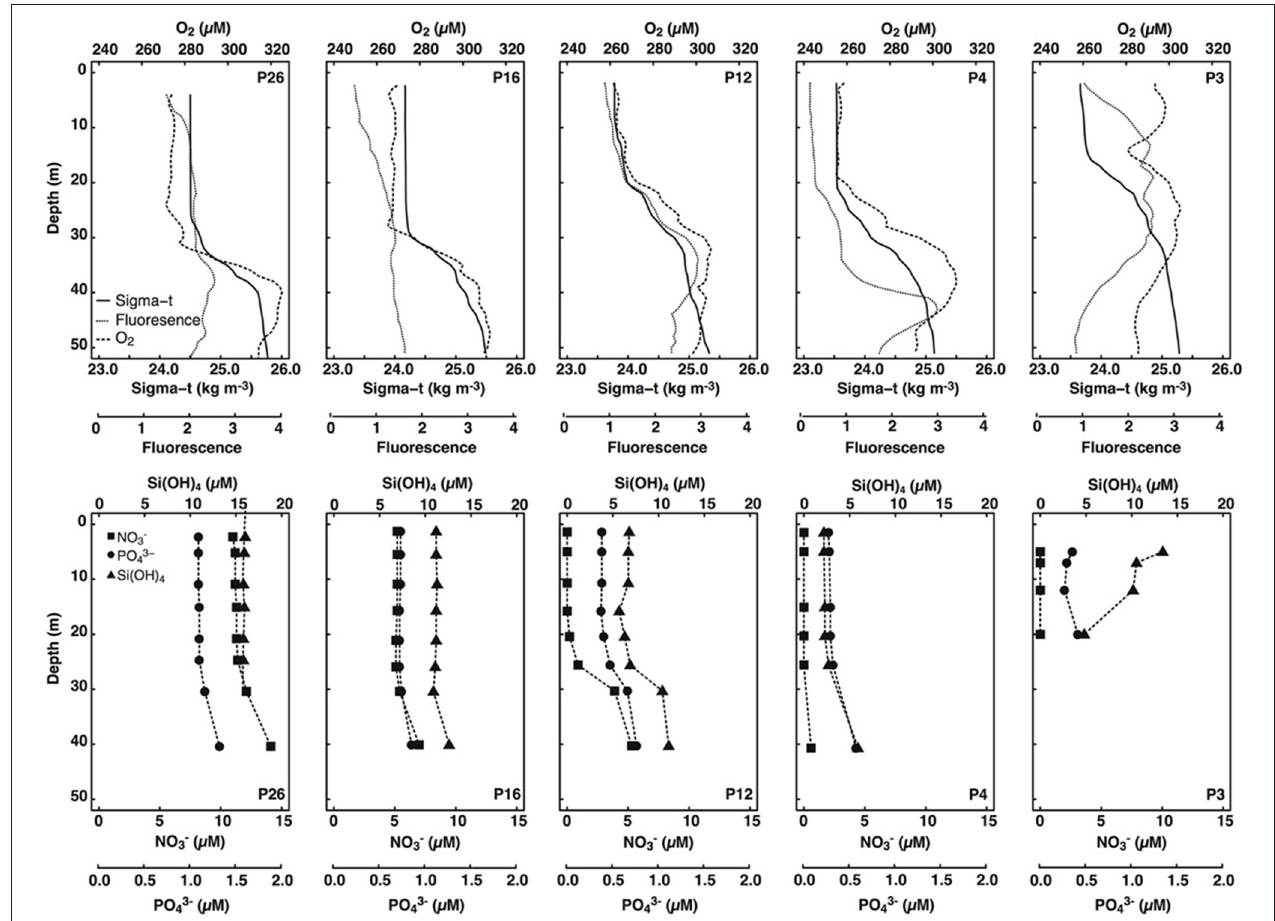
FIGURE 2 | Depth profiles of sigma-t (kg m − 3 ), fluorescence (unitless), dissolved oxygen ( μ M), dissolved nitrate ( μ M), phosphate ( μ M), and silicic acid ( μ M) in surface waters ( < 50 m) of stations sampled along the Line P transect. Only data collected during the same cast were plotted.